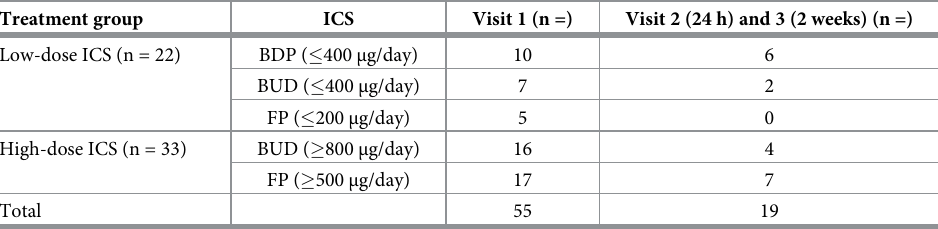
Table 2. Frequency distribution of patient groups attending visit 1 and visits 2 and 3 based on treatment group.